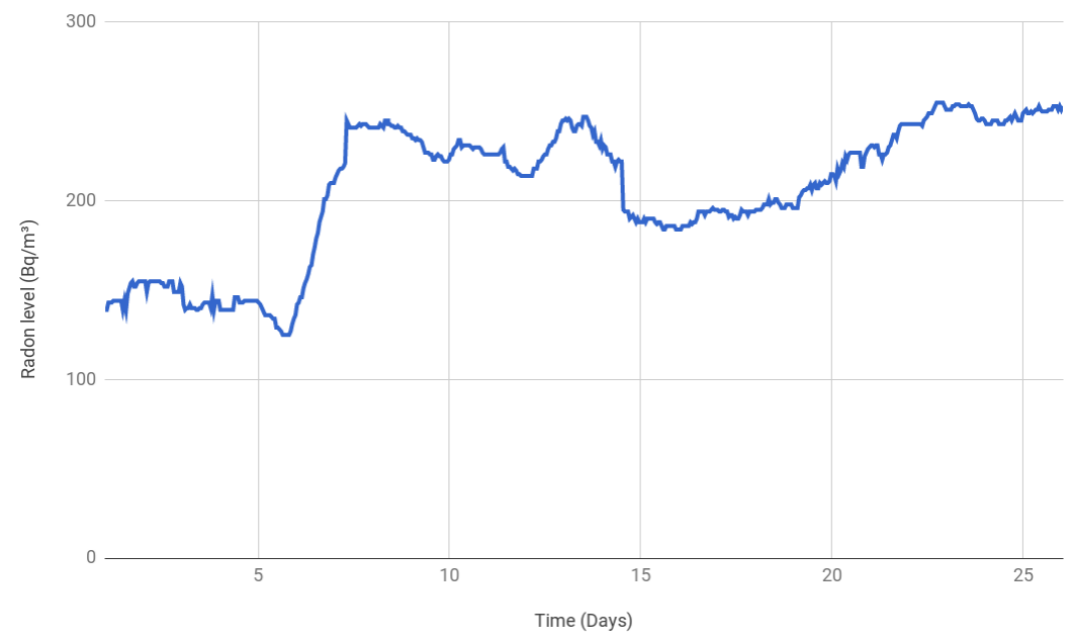
Figure 13. Radon gas concentration over 26 consecutive